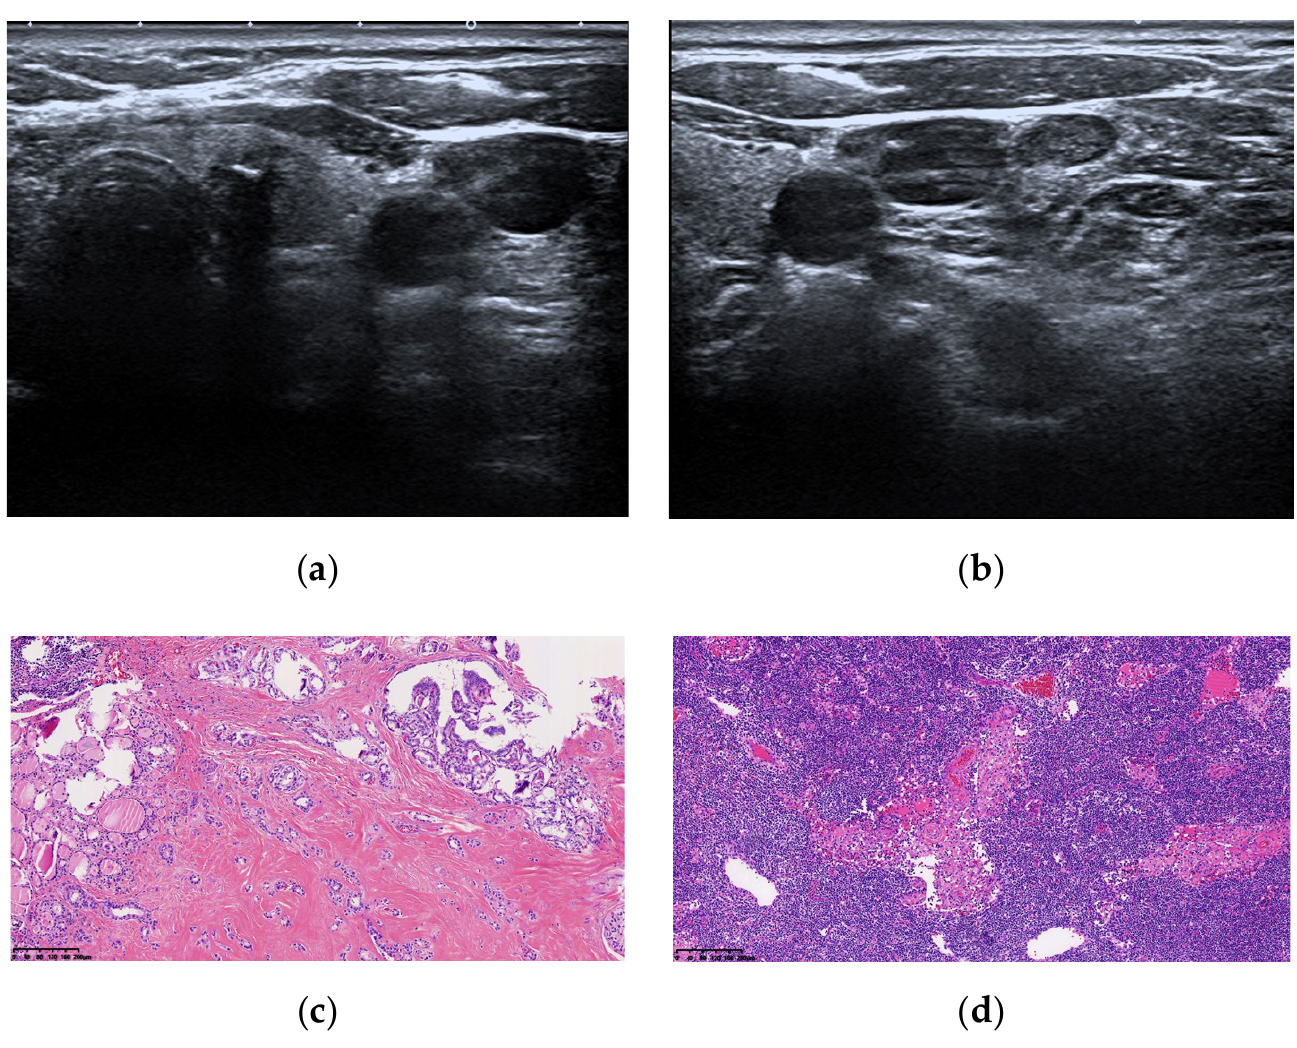
Figure 3. A 57-year-old female patient with a preoperative serum Tg level of 2.95 ng/mL. Ultrasound findings: thyroid left lower lobe nodule, TI-RADS 5 categories ( a ) Left neck IV lymph node enlarge- ment, suspicious metastatic lymph nodes ( b ) combined with puncture if necessary. Postoperative pathology shows papillary thyroid microcarcinoma ( c shows HE staining, magnification ×100). Left cervical lymph node chronic inflammation ( d ) shows HE staining, magnification ×100). Tg, serum thyroglobulin; HE, haematoxylin and eosin; TI-RADS, Thyroid Imaging Reporting and Data Sys- tem.